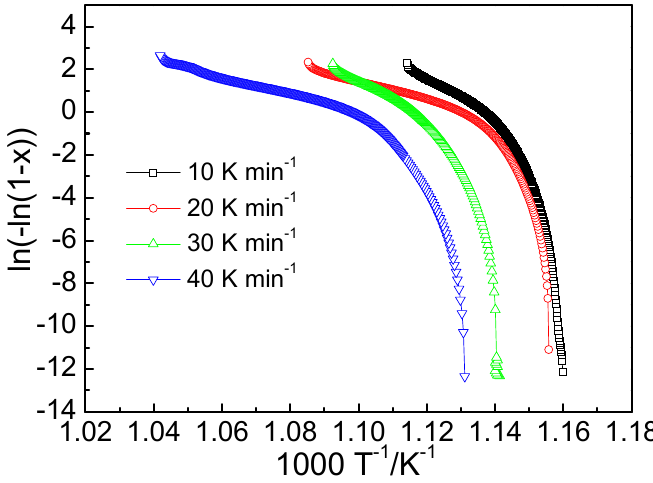
Figure 8. Plots of ln(–ln(1 – x )) against 1000/ T of the Fe 68 Nb 6 B 23 Mo 3 metallic glass (at 10\20\30\40 K/min).